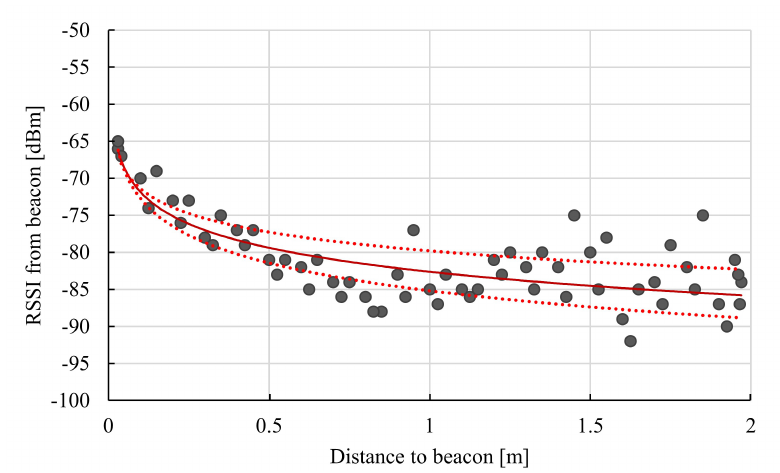
Figure 2. The received signal strength indicator (RSSI) experiments of beacons.